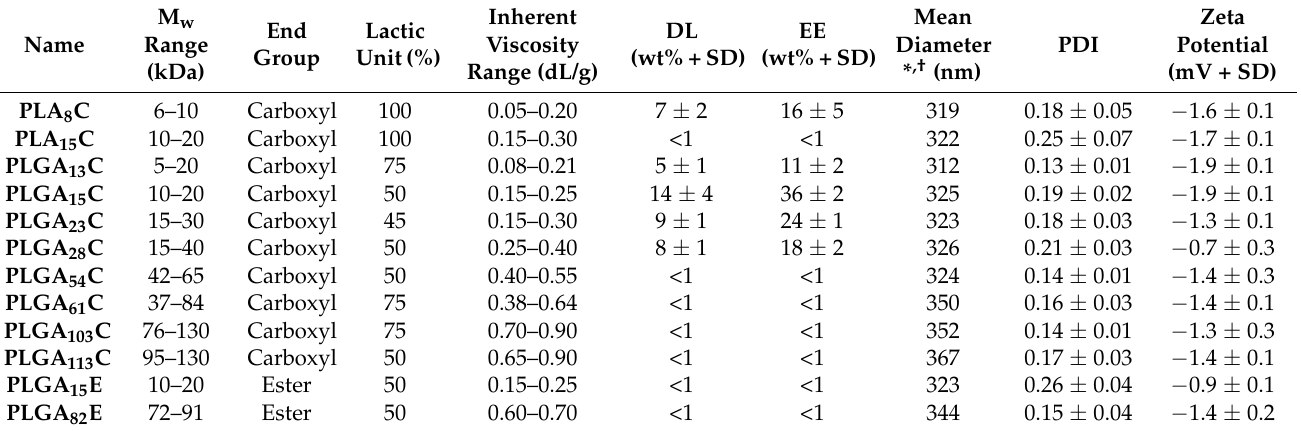
Table 1. VCM encapsulation in NPs with different polymer compositions, effect on DL, EE, mean diameter, PDI, and Zeta potential. PLA and PLGA (co)polymers from EXPANSORB ® were used.